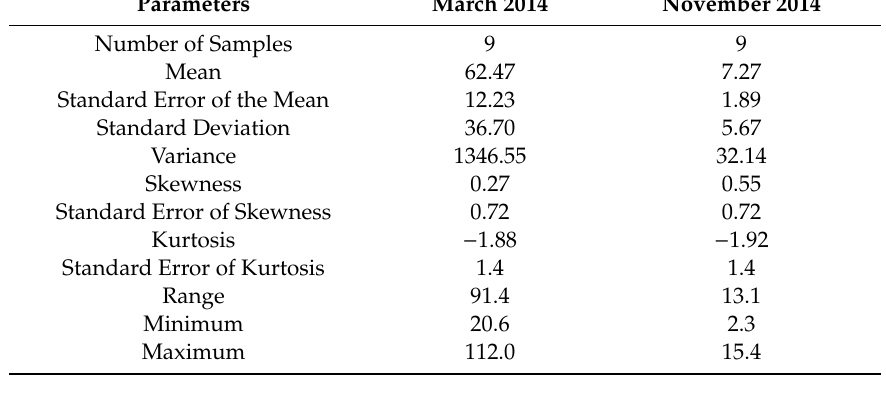
Table 3. Descriptive statistics values of turbidity in March and November 2014.